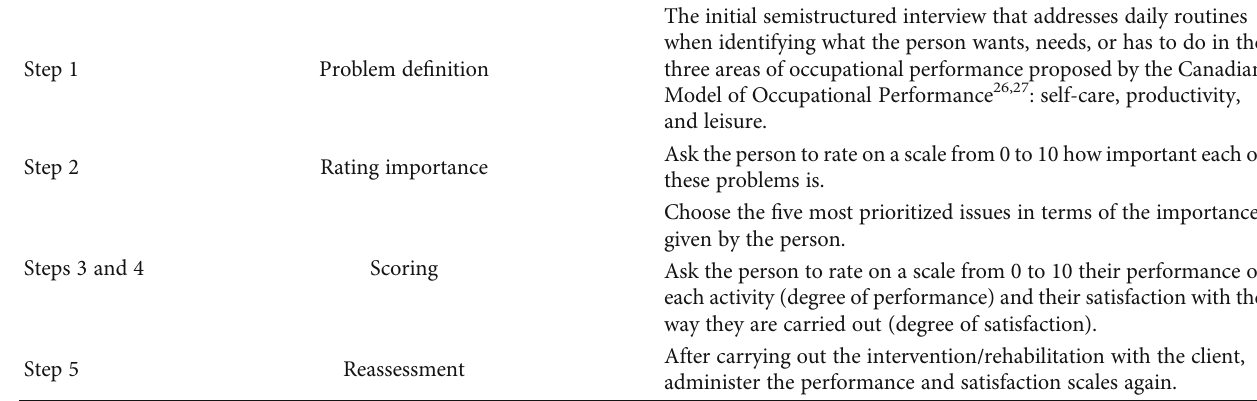
Table 2: Process for the administration of Canadian Occupational Performance Measure.